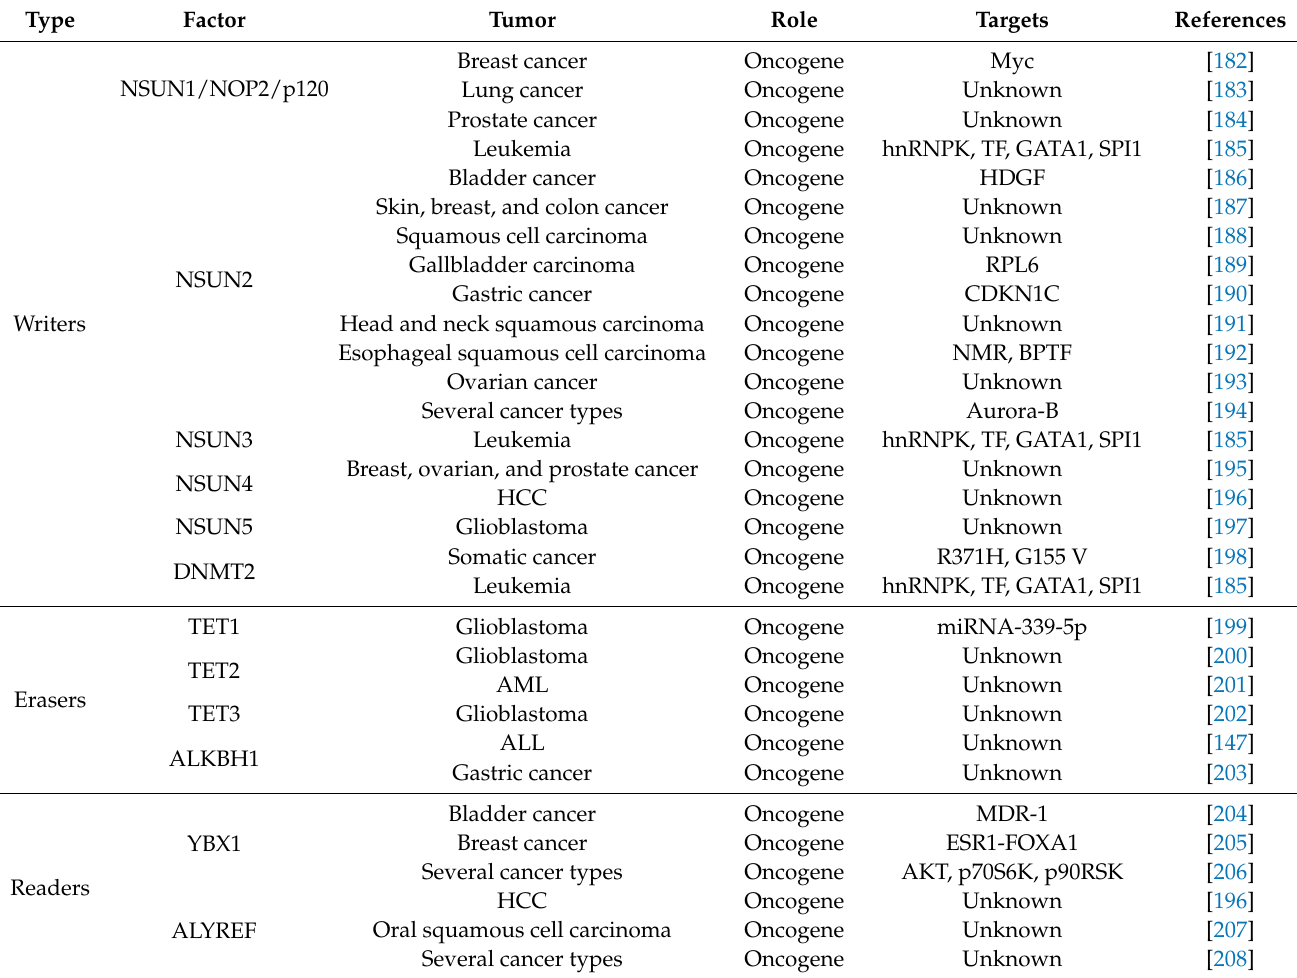
Table 4. Role of the aberrant deposition of m 5 C in cancer. NSUN—NOP2/Sun;